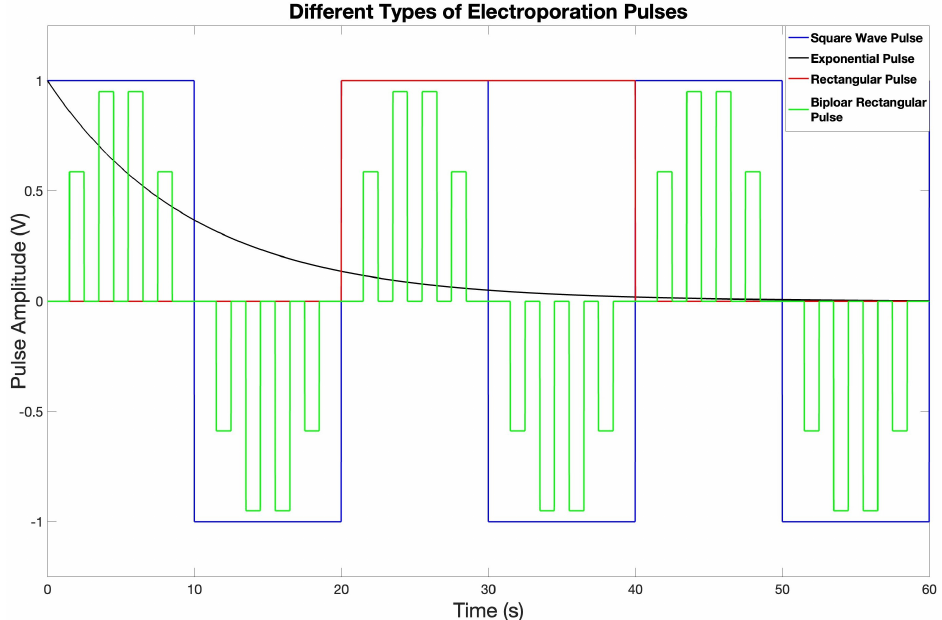
Figure 2. Different type of electroporator waveforms